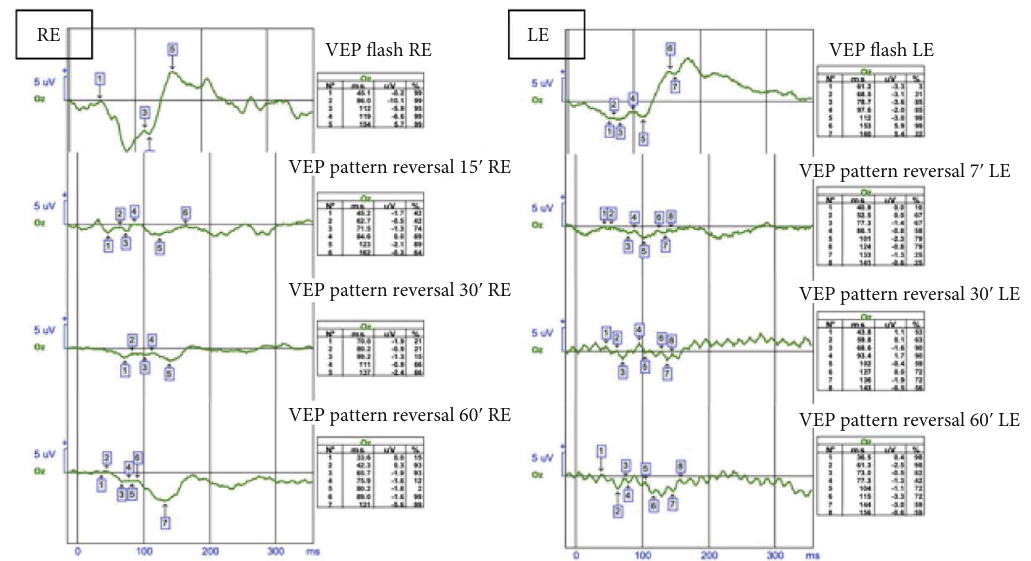
Figure 7: Visual evoked potentials. Comparative visual evoked potentials of the a ff ected eye. N75-74.115 ms, P100-100.225 ms, and P135 were not recorded. Normal left eye VEP functional traces were considered between the normal